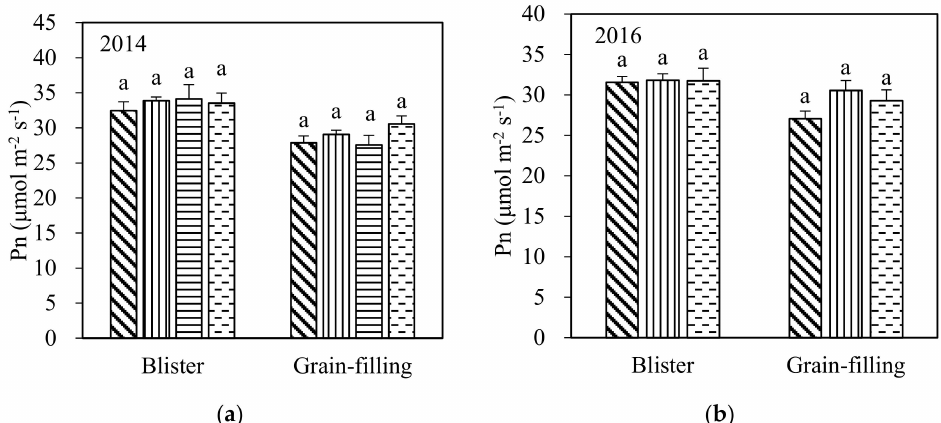
Figure 7. Ear leaf net photosynthesis rate (Pn) at the blister stage and the early grain-filling stage in 2014 ( a ) and 2016( b ). CK, T1, T2, and T3 denote the control, nocturnal warming during the whole growth season, and nocturnal warming during the vegetative and reproductive stages, respectively. The same letters on the pillar indicate no significant difference among the treatments in the same year ( p < 0.05).